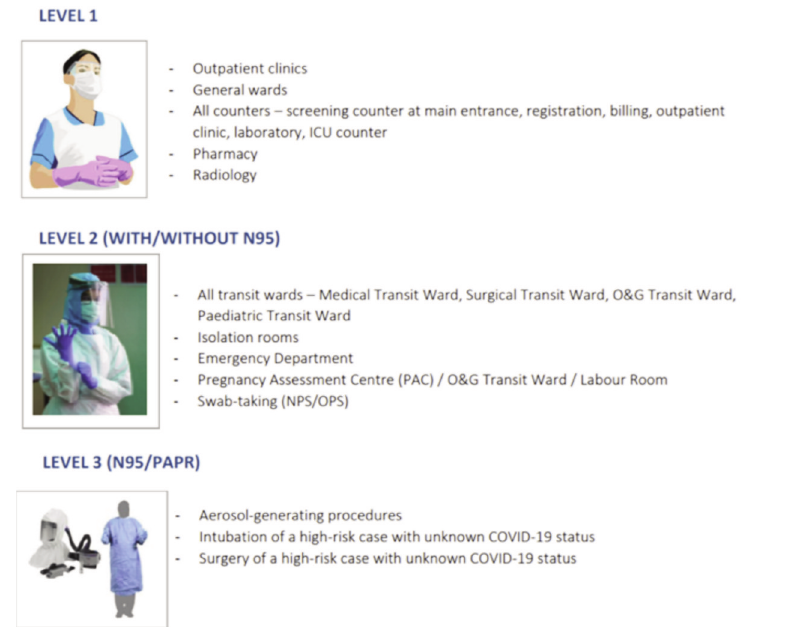
Schematic diagram of the level of personal protective equipment utilised in our Fig. 1: